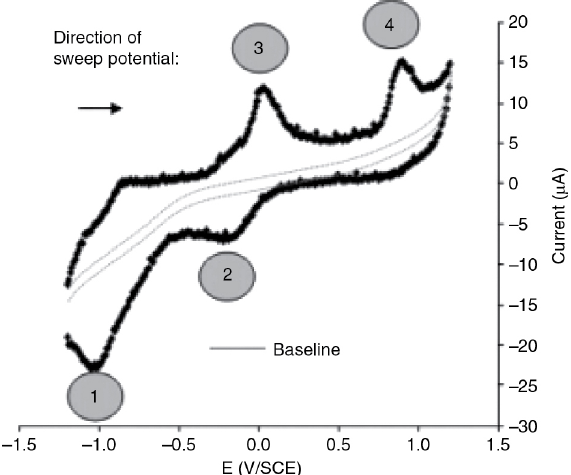
Figure 1: CV of 50 mg/l p -NP in acetate buffer (pH 5.2, ionic strength 0.2 m ), on a polished GCE, under a potential scan rate of 100 mV/s (Pontié et al.